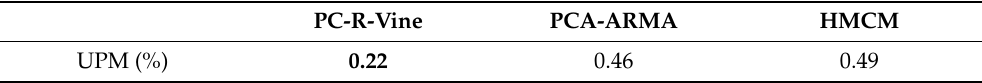
Table 2. Each model’s uncovered percentage results.